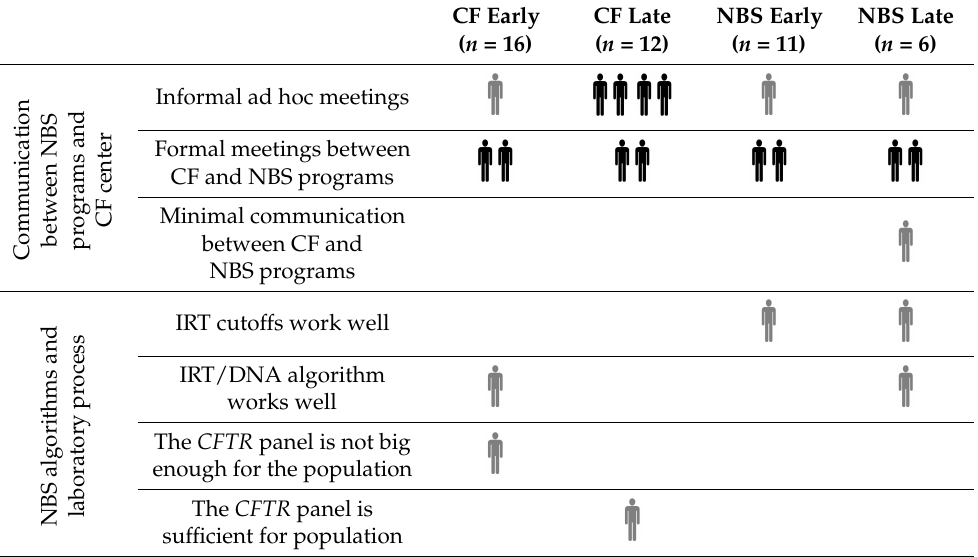
CF Early CF Late NBS Early NBS Late ( n = 16) ( n = 12) ( n = 11) ( n =